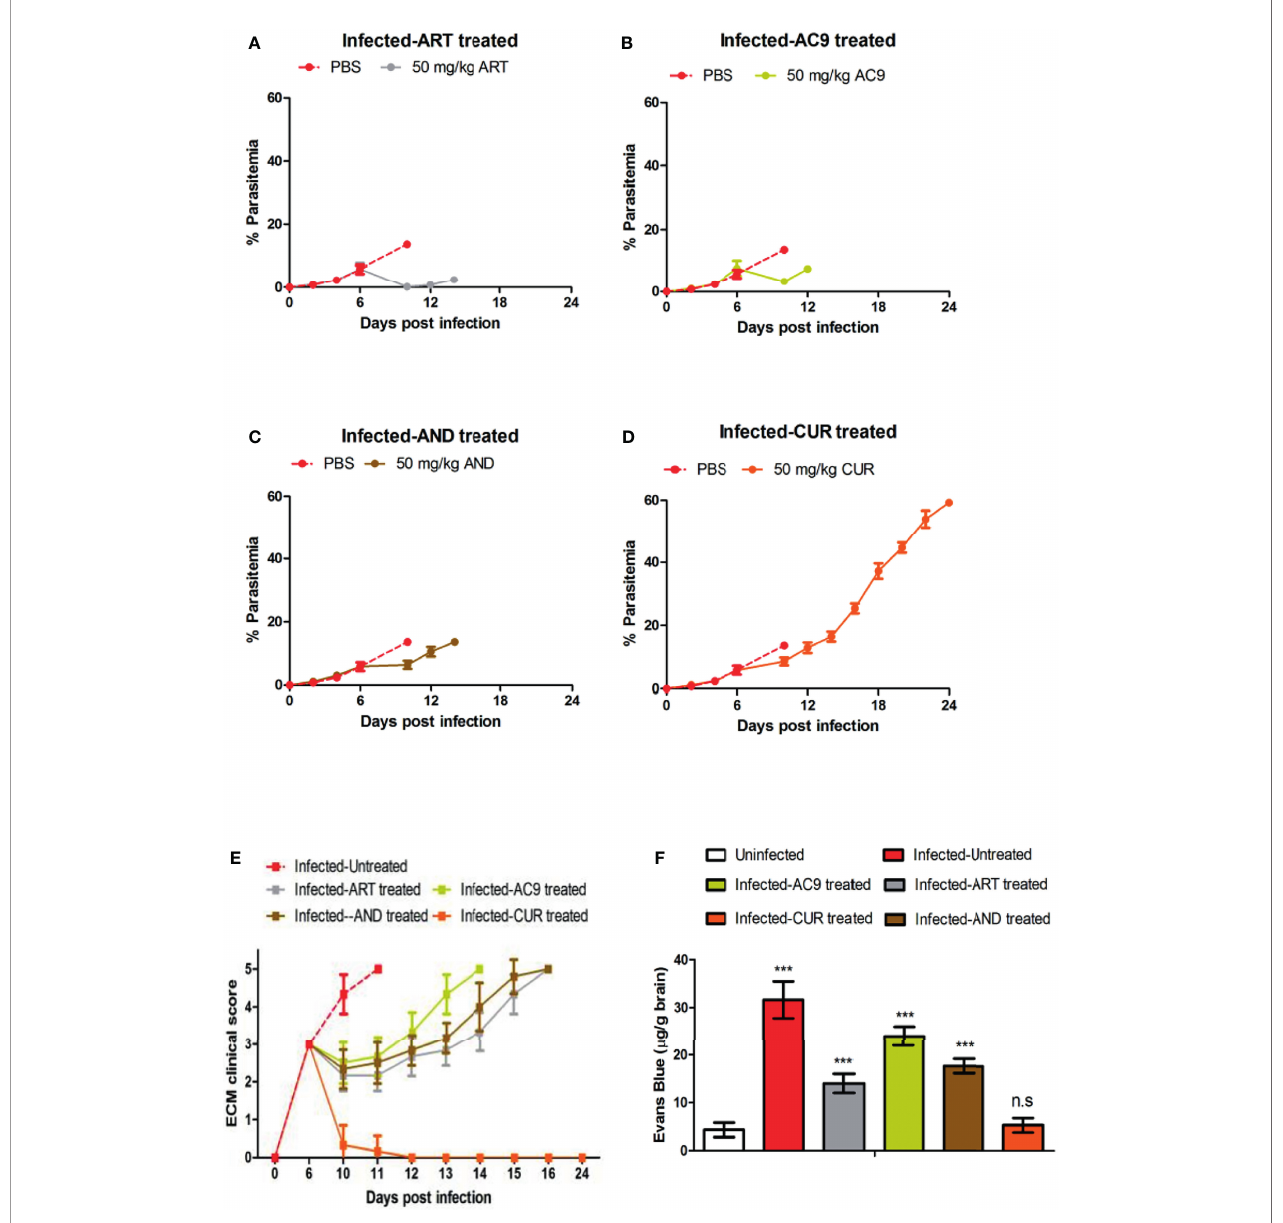
FIGURE 3 | Ef fi cacy of single drug treatments with ART, AC9, AND or CUR in P. berghei ANKA infected C57BL/6 mice was evaluated. Infected-untreated mice were treated with only PBS. Parasitemia of (A) infected-untreated vs infected-ART treated group, (B) infected-untreated vs infected-AC9 treated group, (C) infected- untreated vs infected-AND treated group and (D) infected-untreated vs infected-CUR treated group was recorded. (E) The ECM clinical score for infected-untreated, infected-ART treated, infected-AC9 treated, infected-AND treated, infected-CUR treated groups were monitored and (F) damage to the BBB was assessed by quantitation of Evan ’ s Blue Dye in the brain when the ECM clinical score for infected-untreated group reached 4. Parasitemia, survival curve and ECM clinical score data is representative of 3 independent experiments and data from 6 mice per group has been represented. Evan ’ s Blue Dye quantitation data is expressed as mean ± SD from 3 mice per group. [* P <0.05, ** P <0.01, *** P <0.001, n.s., not signi fi